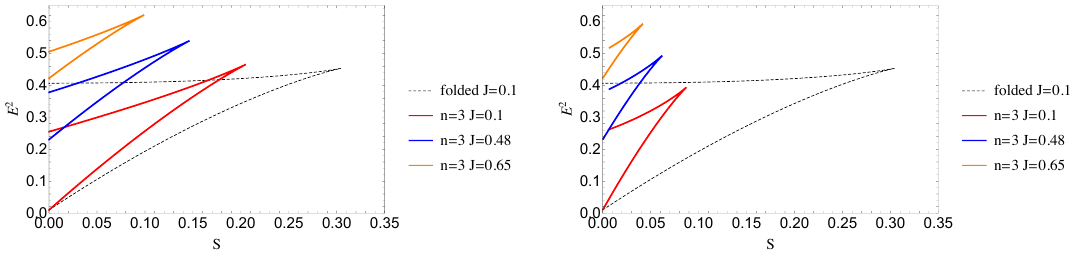
Figure 15 . Regge trajectories of spiky strings with internal charges. The left and right figures are for outward and inward spike solutions, respectively. For comparison, we also illustrate the Regge trajectory of the folded string in the dotted lines. The energy, spin and internal charge are in the units of R/α 0 , R 2 /α 0 and R 2 /α 0 ,